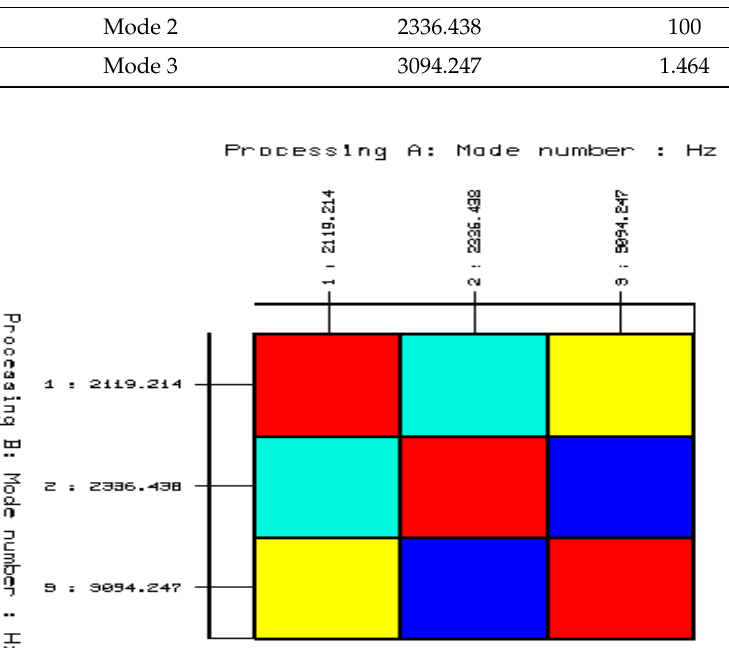
Figure 23. Validation of the selected stable poles and the corresponding modes of the free vibra- tions using the AutoMAC function (convergence percentage between the modes of on-vibrations determined from the stabilization diagrams: blue = 4% yellow = 28% red = 100% turquoise = 15%).